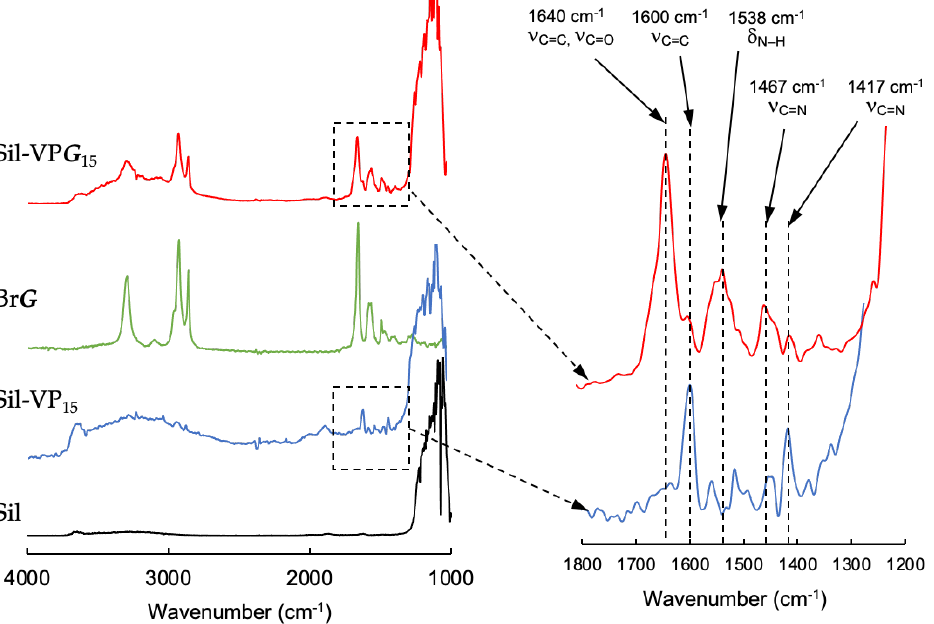
Nanomaterials 2021 , 11 , x FOR PEER REVIEW Figure 1. Diffuse reflectance FT − IR spectra of Sil, Sil − VP 15 , Br G , and Sil − VP G 15 . Figure 1. Diffuse reflectance FT−IR spectra of Sil, Sil−VP 15 , Br G , and Sil−VP G 15 .